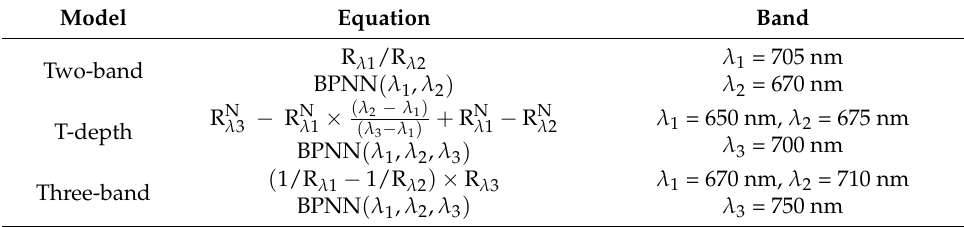
Table 1. The chlorophyll-a (Chl-a! retrieval models and the